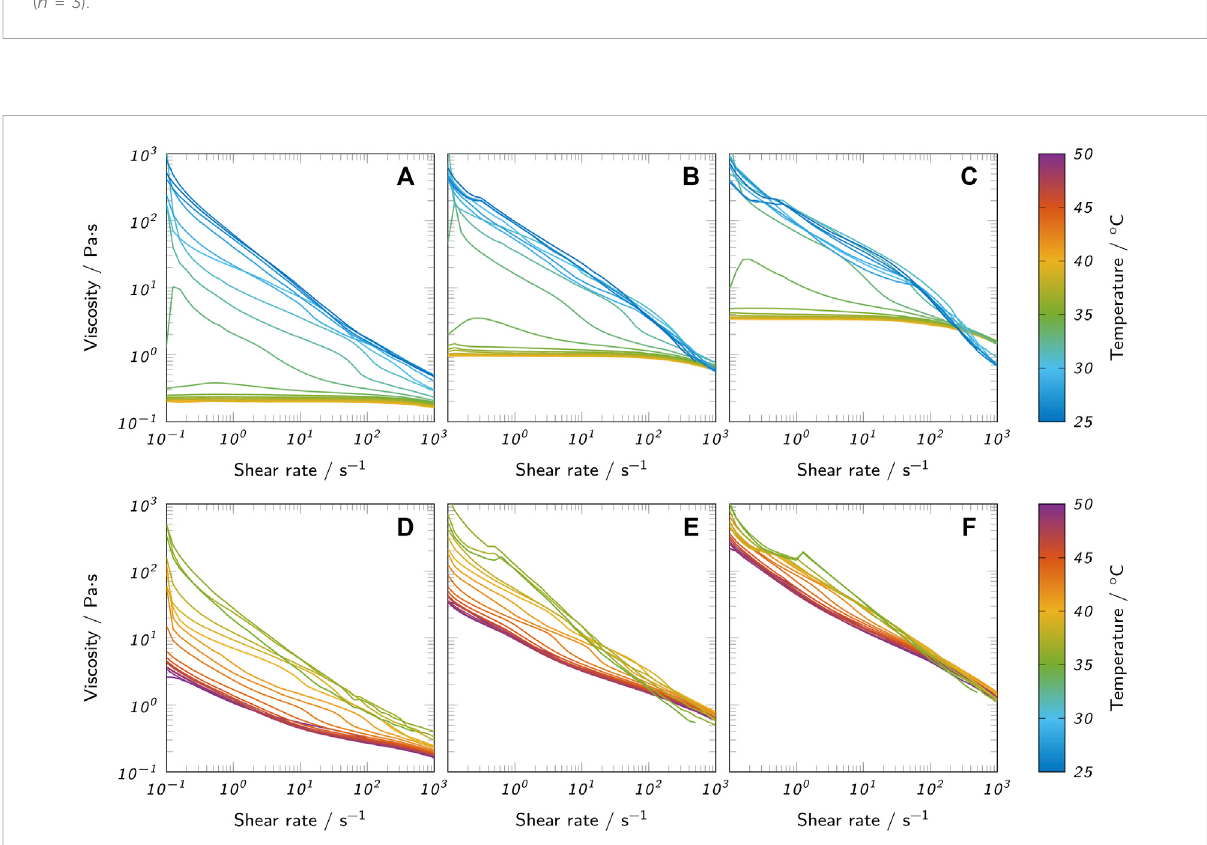
FIGURE 5 Flowcurves ofallpreparedbioinksatdifferenttemperatures. (A) 3%low-melt agarose, (B) 4.5%low-melt agarose, (C) 6%low-meltagarose,